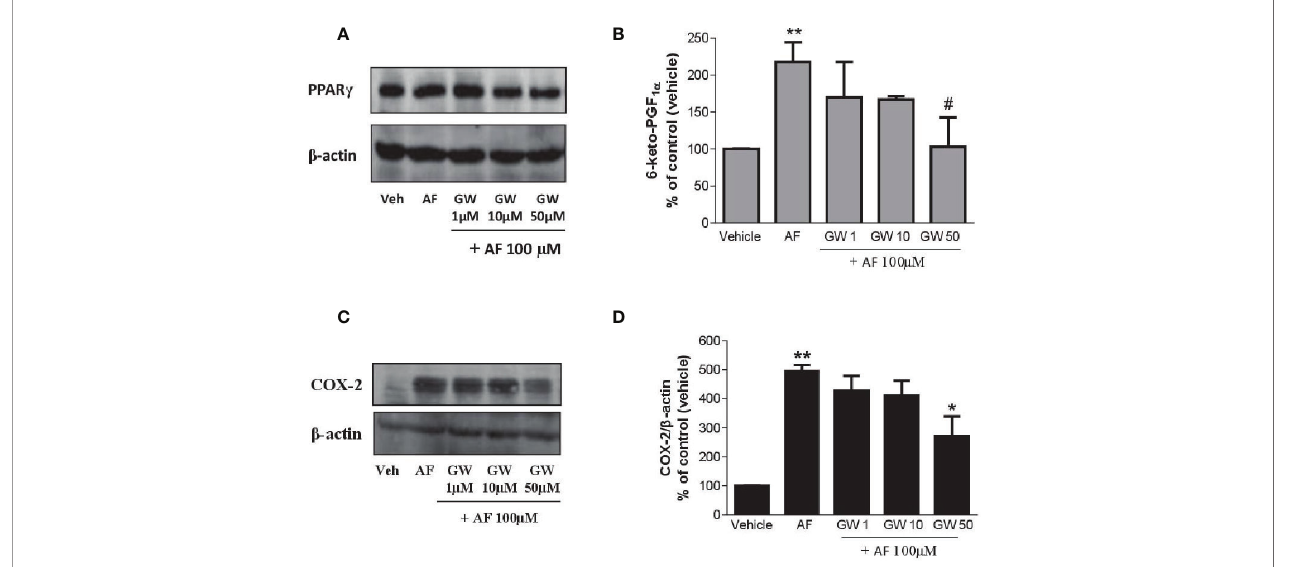
FIGURE 7 | Effects of a PPAR g antagonist on the increase of PGI 2 biosynthesis and COX-2 expression by AF3485 in HUVEC. HUVEC (1x10 6 cells) were incubated with AF3485 (100 µM) alone or in combination with GW9662 (1 – 50 µM) for 24 h. (A) Western blot analysis of PPAR g is reported; b -actin levels were used as protein loading control. (B) Assessment of 6-keto-PGF 1 a in the conditioned medium of HUVEC by immunoassay; data are reported as percentage of control (vehicle). **P < 0.01 versus vehicle; # P < 0.05 versus AF3485 100 µM. (C) Western blot analysis of COX-2; b -actin levels were used as protein loading control. (D) Densitometric analysis of COX-2 expression normalized to b -actin levels; results are reported as % of control (DMSO vehicle) (mean ± SEM, n = 3); **P < 0.01 versus control (DMSO); *P< 0.05 versus AF3485 100 µM (One-way ANOVA and Student's t-test). COX,